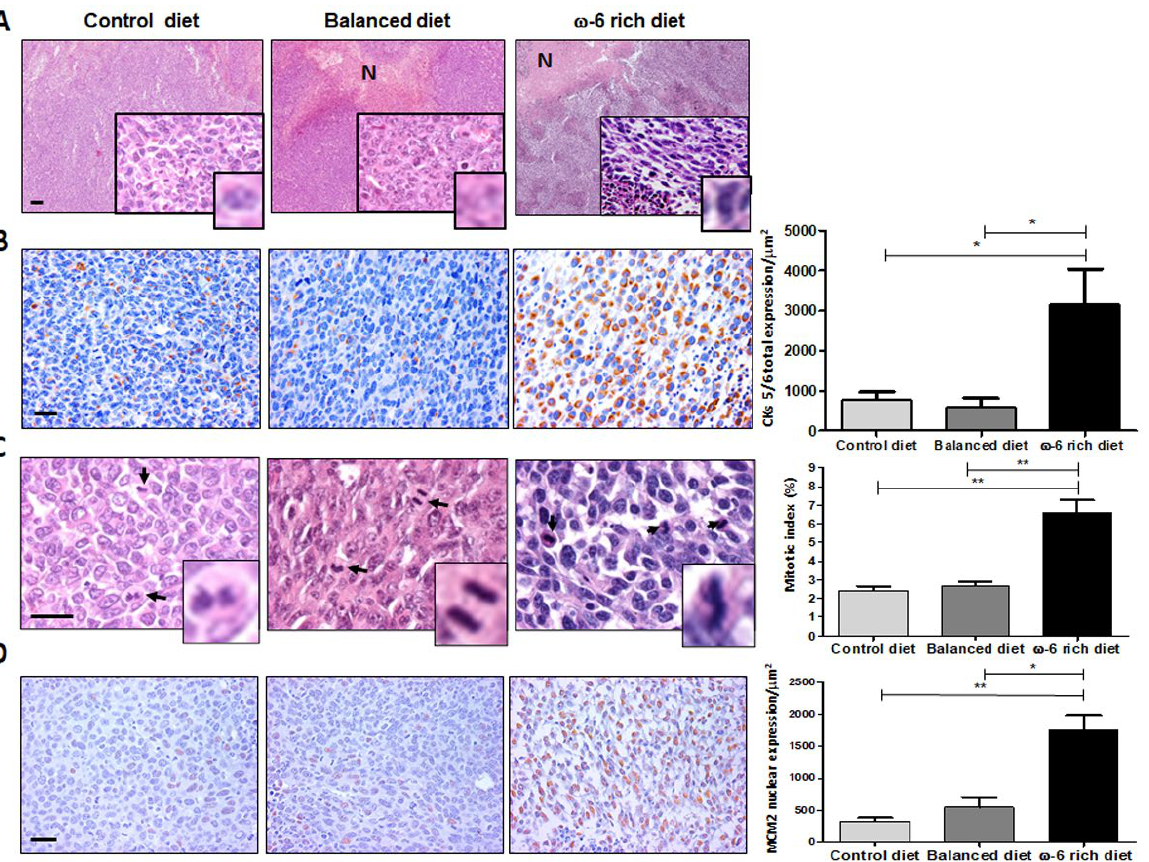
Figure 2. ω -6 PUFAs induce a phenotype of greater tumor aggressiveness and increased cell prolif- eration. ( A ) Representative photomicrographs of cross sections of tumor dyed with H&E from the different groups of mice fed control diet, PUFA-balanced diet, and ω -6 rich diet. ( B ) Immunostaining and analysis of CK5/6 expression (* p < 0.05). ( C ) Mitotic index analysis, statistical differences are shown (** p < 0.01). ( D ) Immunostaining and analysis of MCM2 expression, statistical differences are shown (** p < 0.01 and * p < 0.05). Identifiers: (N) necrosis areas, (black arrows) cells undergoing a mitotic process. ( A ) Scale bar: 200 µ m. ( B – D ) Scale bar: 20 µ m. The data are expressed as the mean + SEM, n =